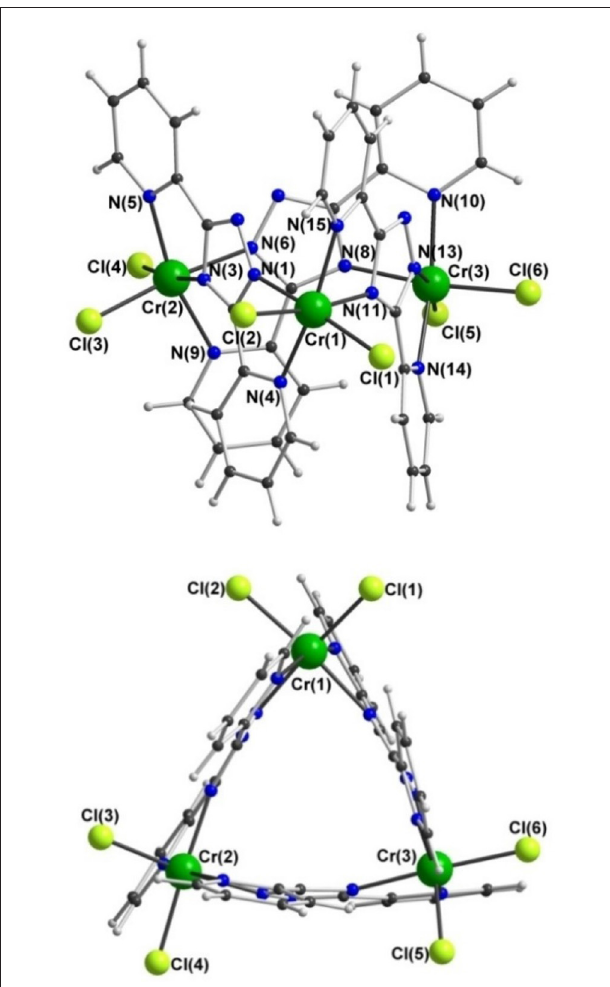
FIGURE 5 | Two views of the molecular structure of [Cr III (dpt)Cl 2 ] 3 · 1.75MeCN · 0.25CH 2 Cl 2 (3); for clarity solvents of crystallization are not